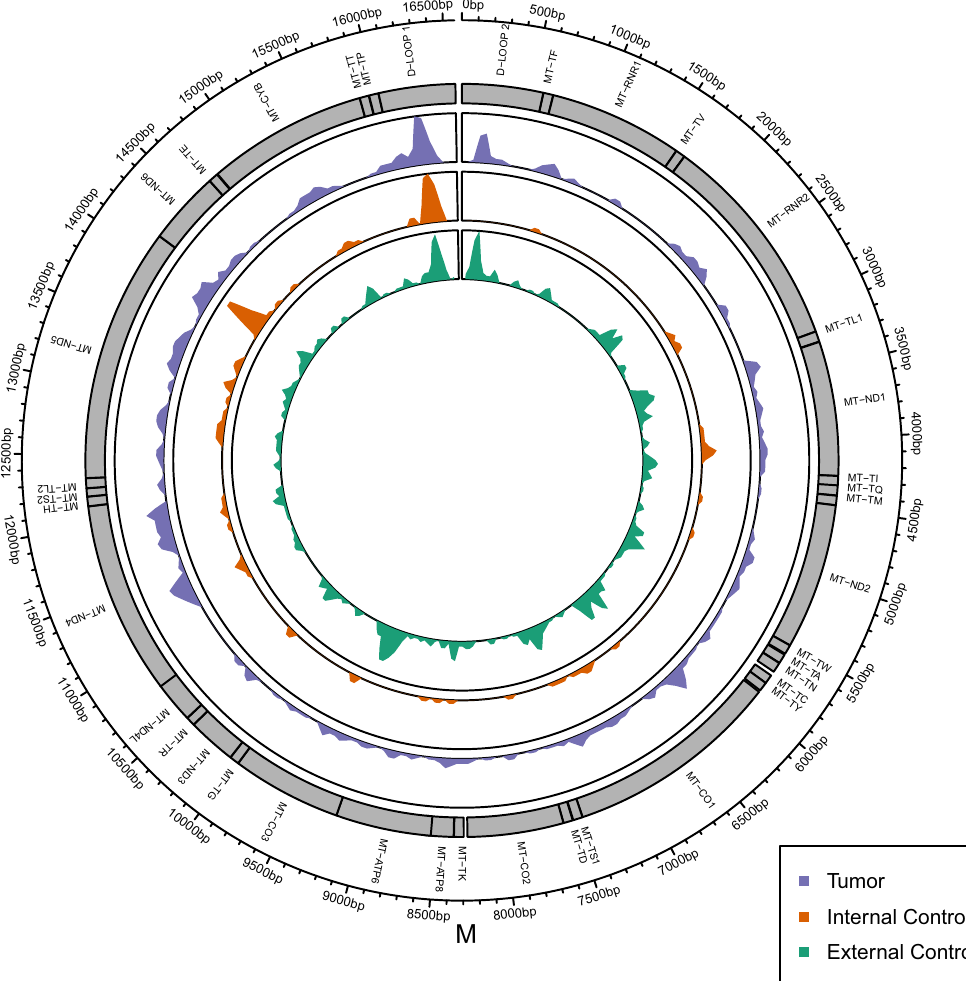
Figure 4. Distribution of heteroplasmic variants in the mitochondrial genome for all groups: tumor, internal control and external control. Peaks represent the number of variants. Genomic length and gene division are also